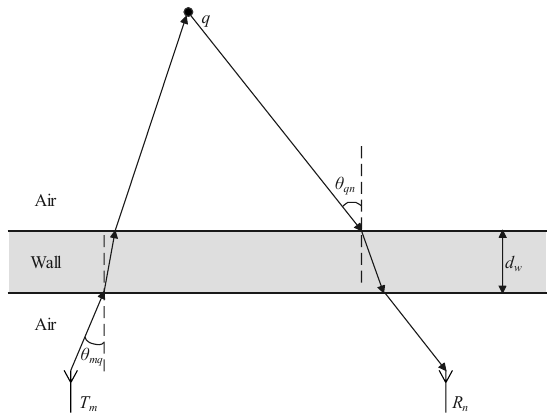
Figure 2. Propagation path for through-wall